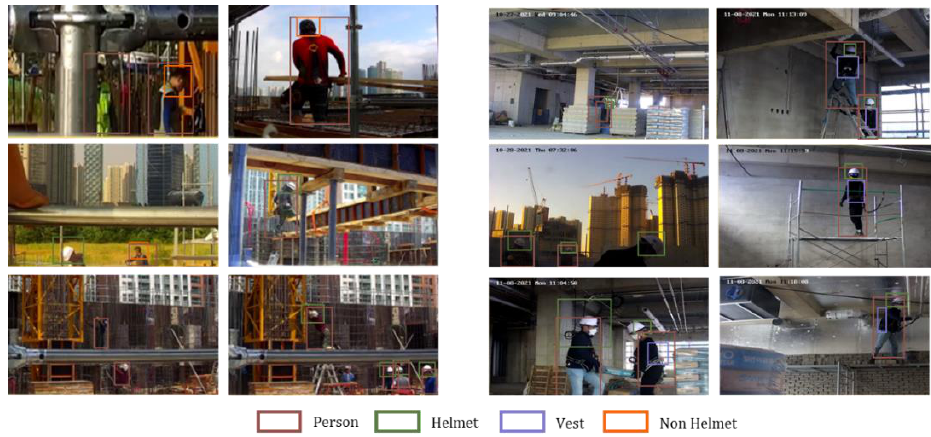
Figure 16. Analysis result of image sample using YOLO v2.